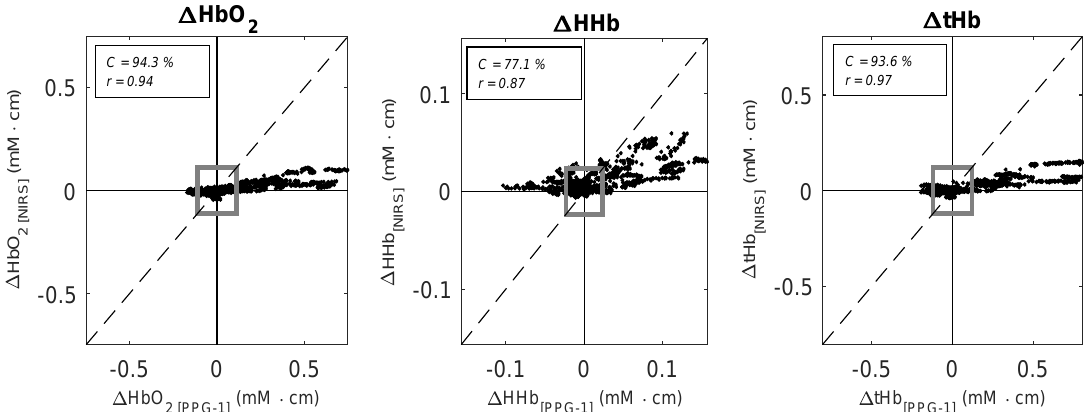
Figure 5. Four-quadrant plots analysis between ∆ HbO 2 , ∆ HHb, and ∆ tHb estimated by NIRS (y-axis) and the PPG-1 sensor (x-axis) during the tilting protocol. Dotted lines represent the line of identity. A total number of n = 100 pair points for each subject were used for the plots. The grey square indicates the 15% exclusion zone.